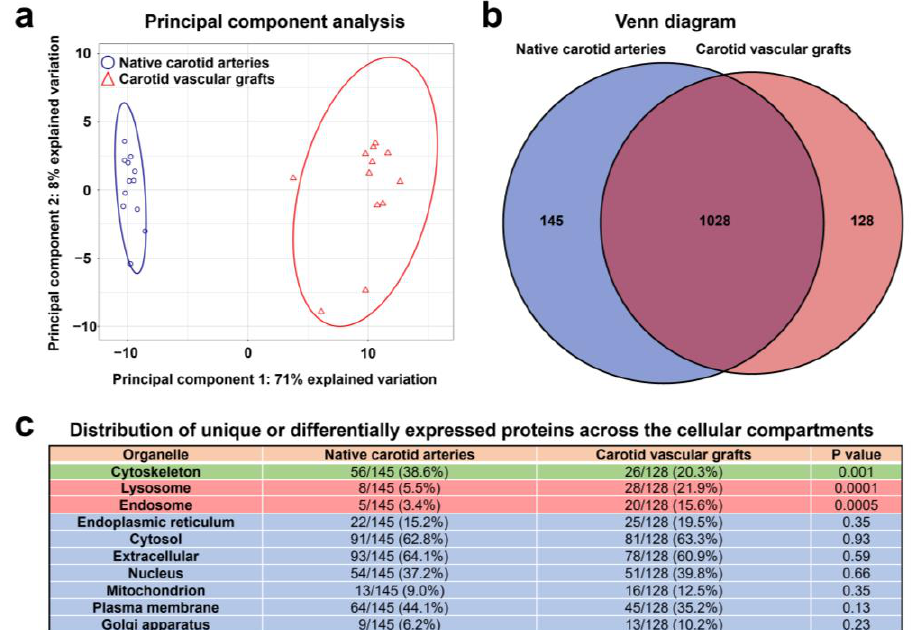
Figure 9. Shotgun proteomics analysis of TEVGs and contralateral carotid arteries by UHPLC-MS/MS. ( a ) Principal component analysis demonstrates clear discrimination of native carotid arteries (blue circles) and TEVGs (red triangles) implanted into the ovine carotid artery for 6 months, each point represents one sample. ( b ) Venn diagram showing the number of proteins unique or significantly overexpressed in the native carotid arteries (145) and TEVGs (128). ( c ) Distribution of differentially expressed proteins across the cellular compartments (annotated according to the COMPARTMENTS database); note the overrepresentation of cytoskeleton proteins in the native carotid arteries and abundance of lysosomal and endosomal proteins in the TEVGs.